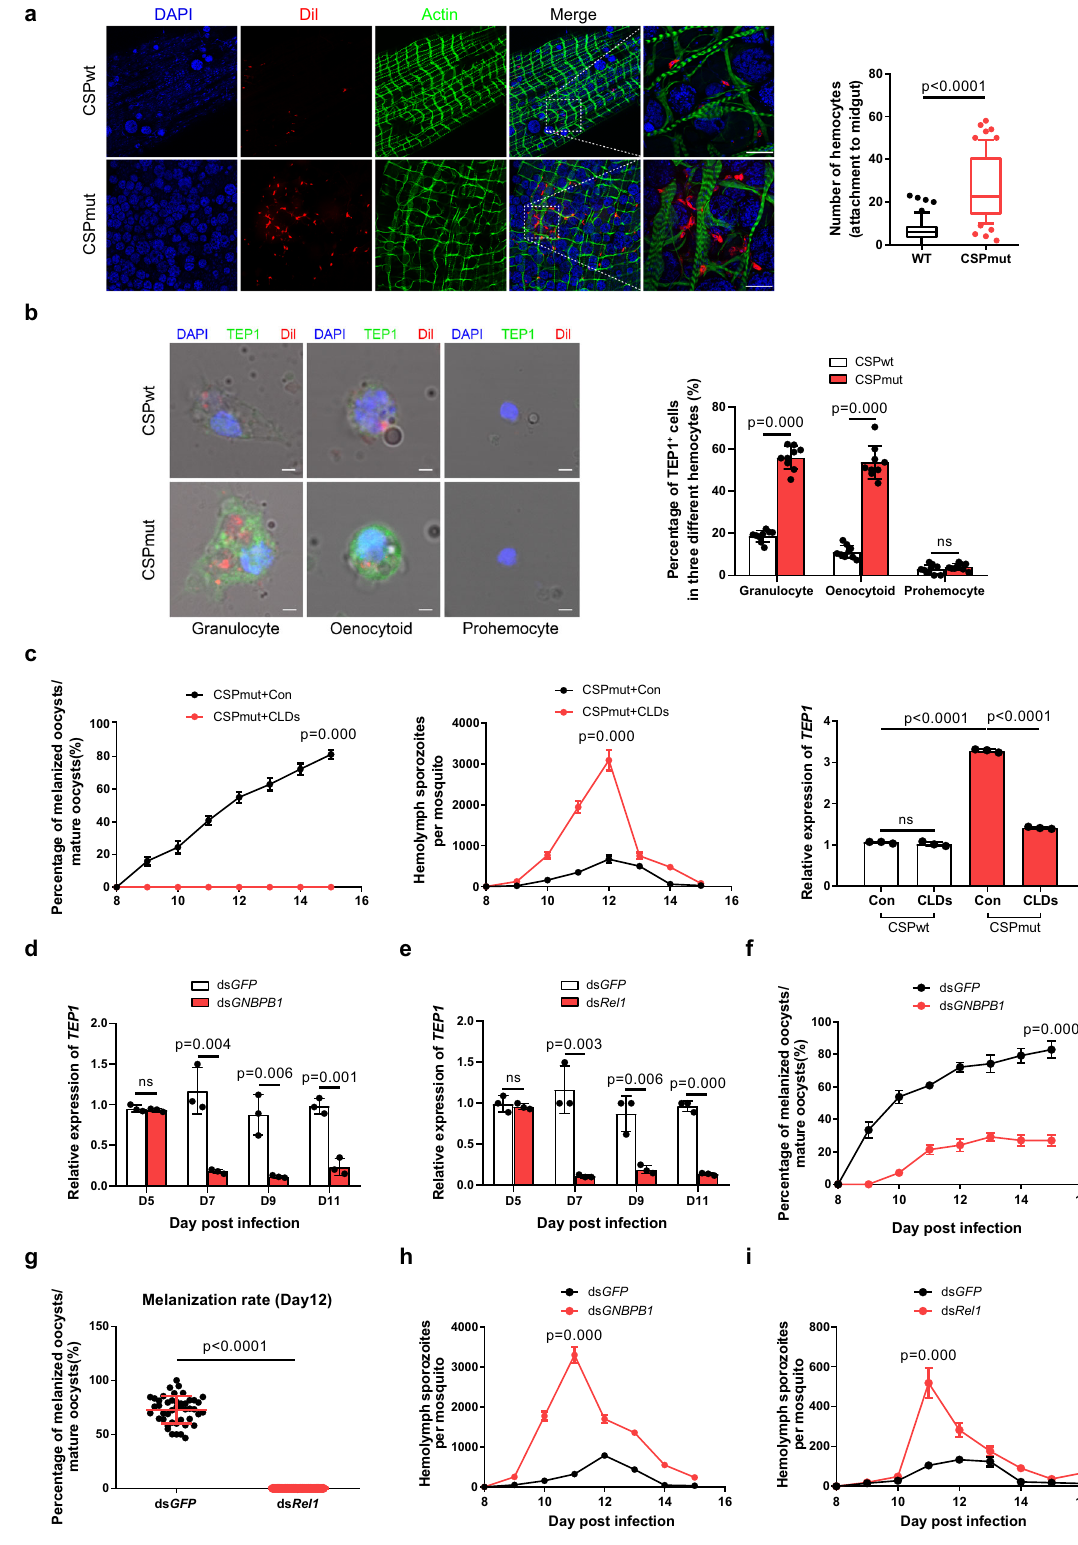
involved in the IMD, JNK, and STAT signaling pathways was found between CSP wt - and CSP mut -infected mosquitoes. How- ever, those belonging to the Toll signaling pathway, such as Gram-negative binding protein B1 ( GNBP-B1 ) (ASTE016199) and Relish-like protein 1 ( Rel1 ) (ASTE011378), were signi fi cantly upregulated (Supplementary Fig. 6a), which was further validated